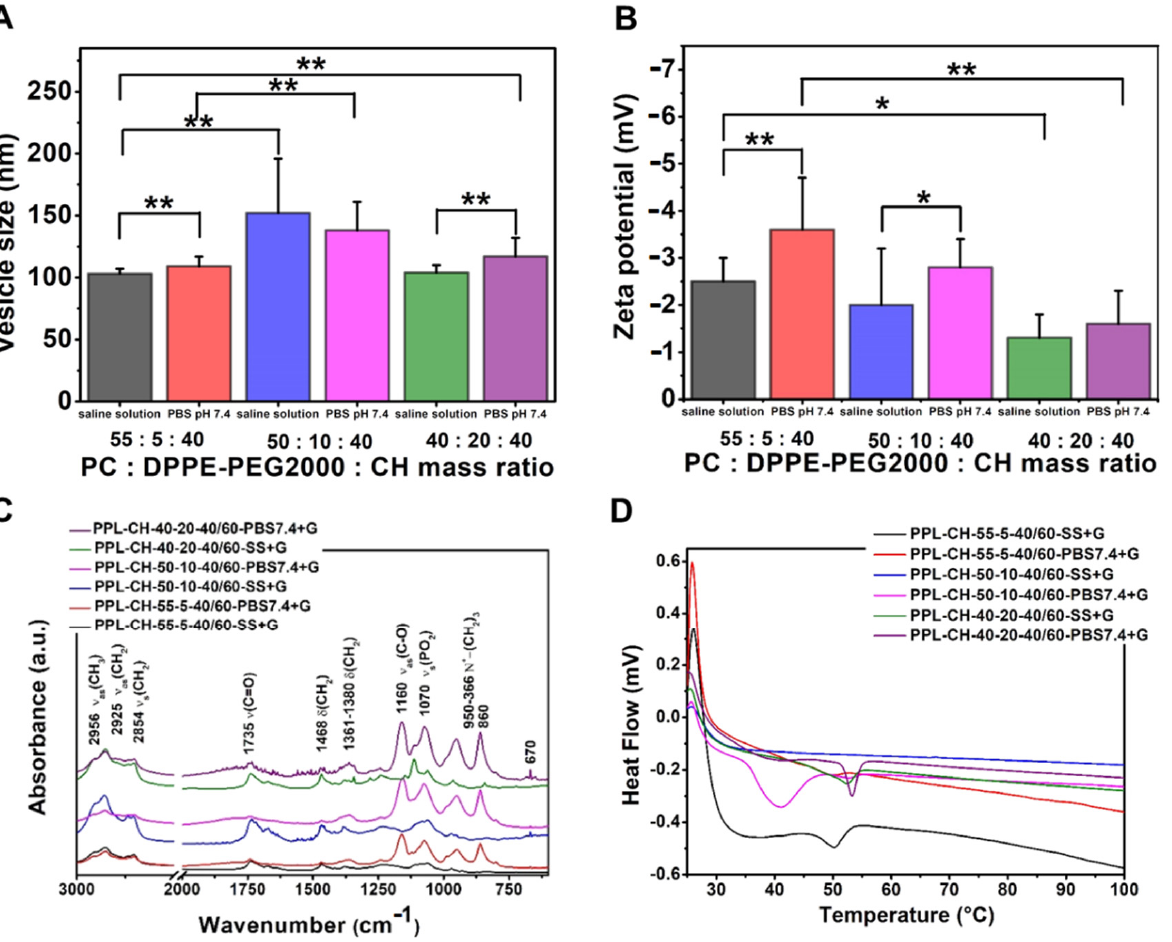
Figure 7. Characteristic features of the liposome samples prepared from different ratios of phosphatidylcholine (PC), PEGylated phosphatidylethanolamine (DPPE-PEG 2000 ) and cholesterol (CH) at 60 °C, hydrated with saline solution or PBS pH 7.4, and lyophilised with glucose as cryoprotectant, presenting the results of the investigations: vesicle size and zeta potential analysis ( A , B ), differential scanning calorimetry ( C ) and Fourier-transform infrared spectroscopy ( D ). *: p < 0.05; **: p < 0.01 Table 9. Measurement results of the liposome samples prepared from different phosphatidylcholine (PC), PEGylated phosphatidylethanolamine (DPPE-PEG 2000 ) and cholesterol (CH) ratios at 60 °C, hydrated with saline solution or PBS pH 7.4 and lyophilised with glucose as cryoprotectant.